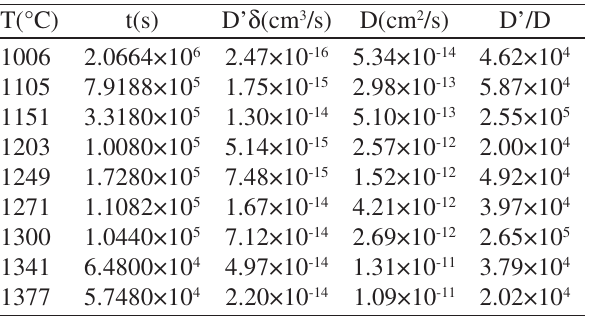
Table 1. Experimental conditions and results for zinc diffusion in polycrystalline